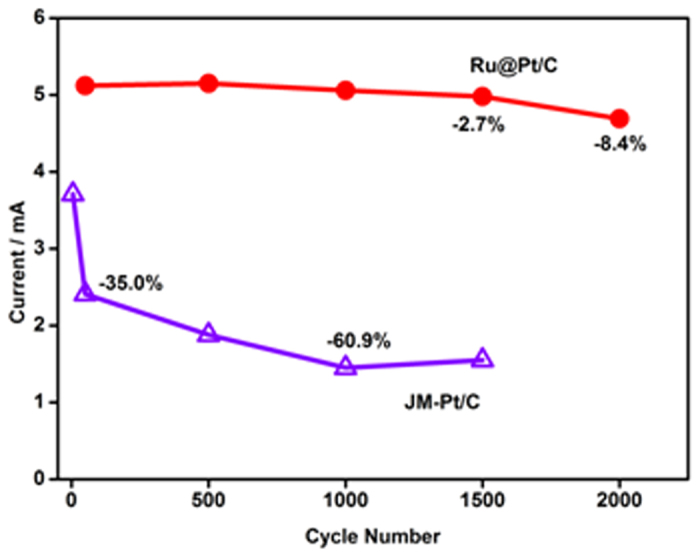
The relationship between the peak current of the anodic oxidation of methanol and the cycling numbers for Ru@Pt/C and JM-Pt/C.All data were recorded in a solution of 0.1 M HClO4 and 1 M CH3OH at room temperature and a scanning rate of 50 mV s−1.